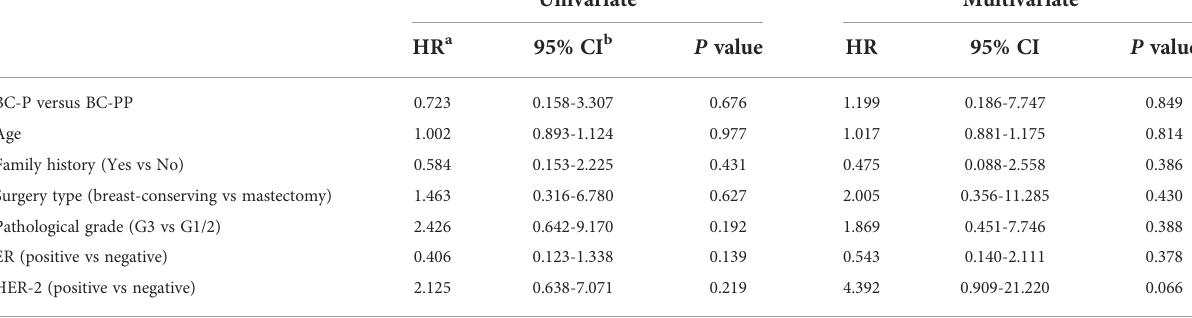
TABLE 3 Factors associated with recurrence among BC-P patients and BC-PP patients.